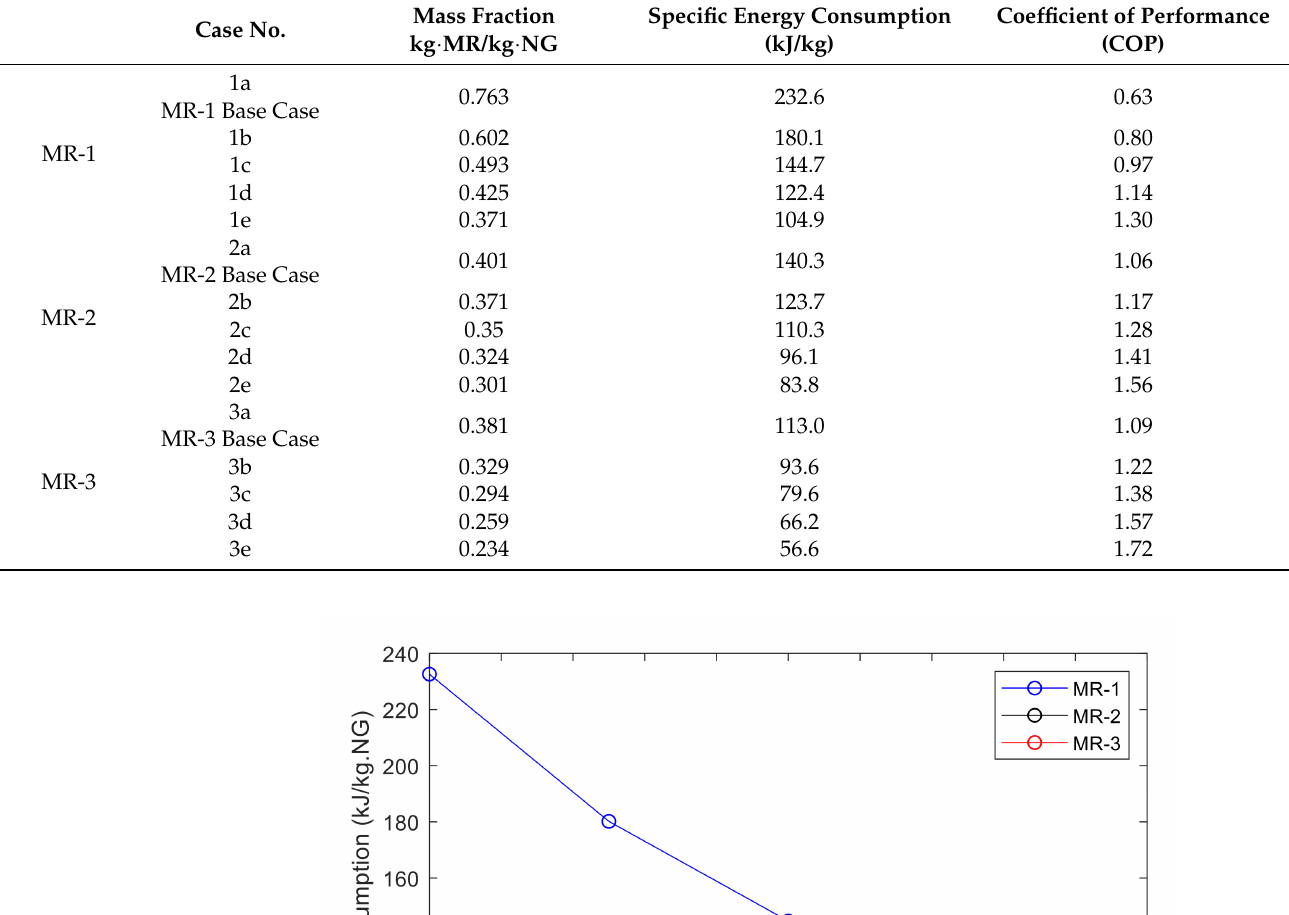
Table 6. Thermodynamic cycle performance comparison of each case study.